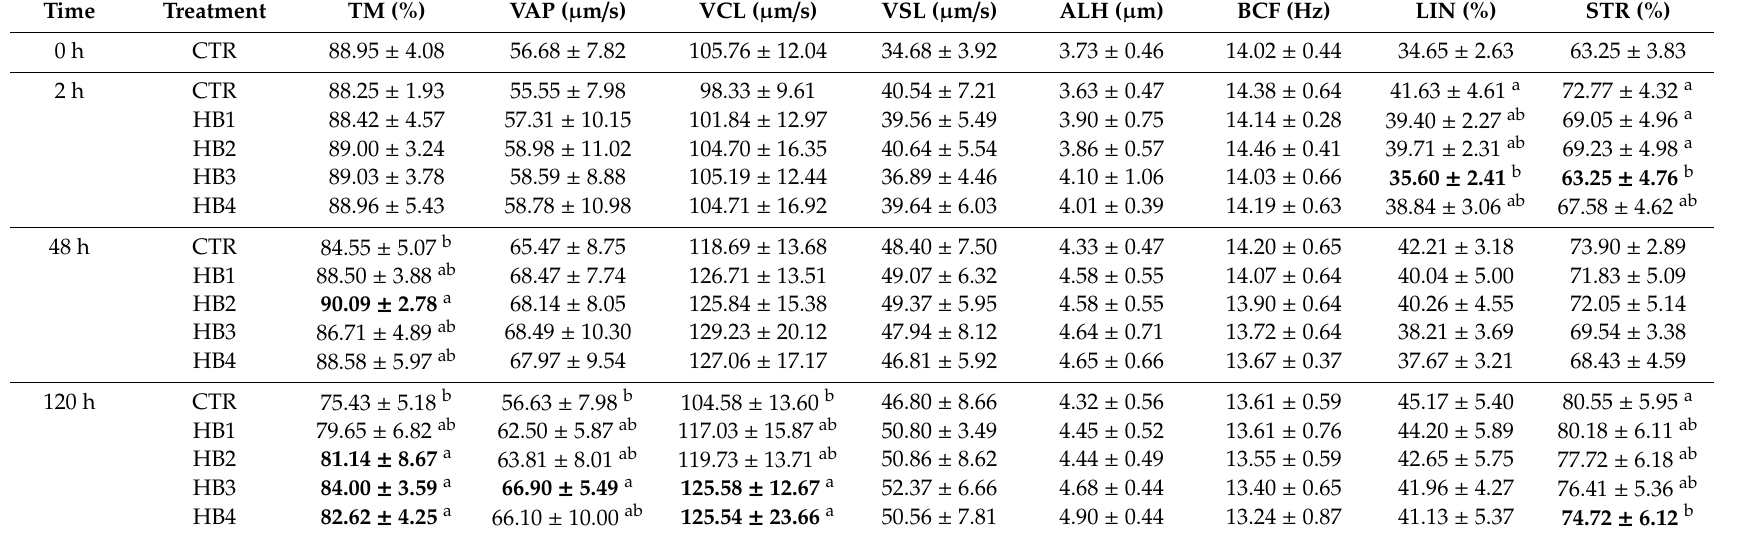
Table 2. Motility and kinetic parameters of boar sperm during semen storage at 17 ◦ C and supplemented with honeybush